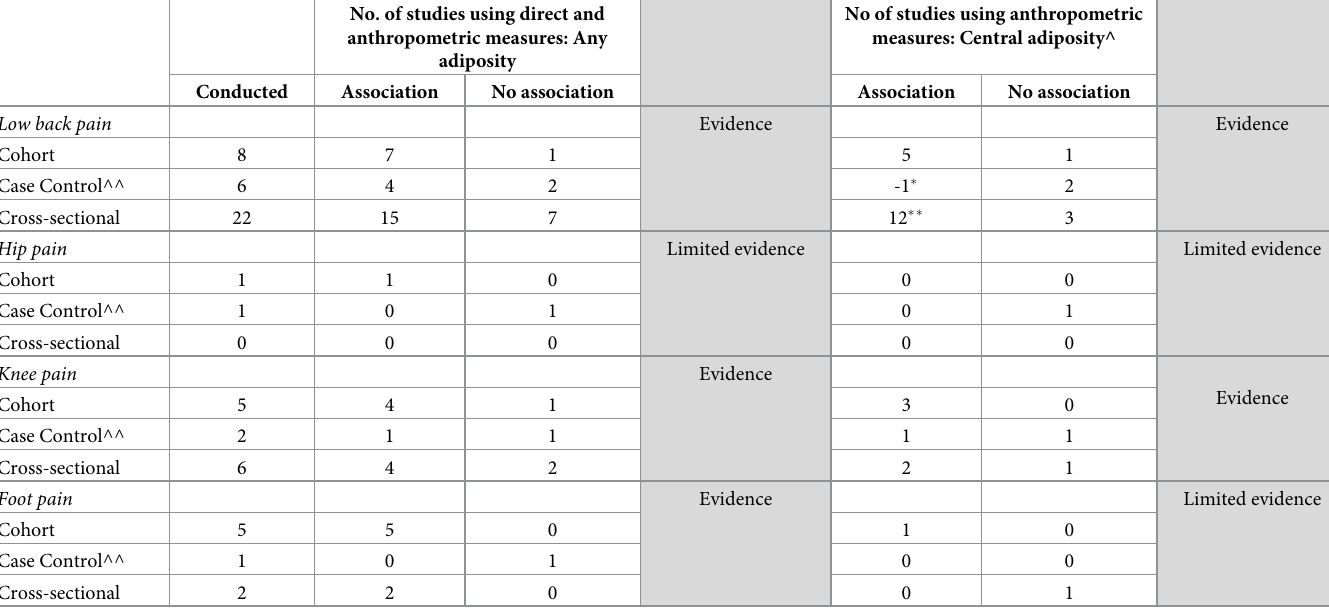
Table 3. Summary of the evidence examining the relationship between any and central adiposity and back and lower limb pain. No. of studies using direct and anthropometric measures: